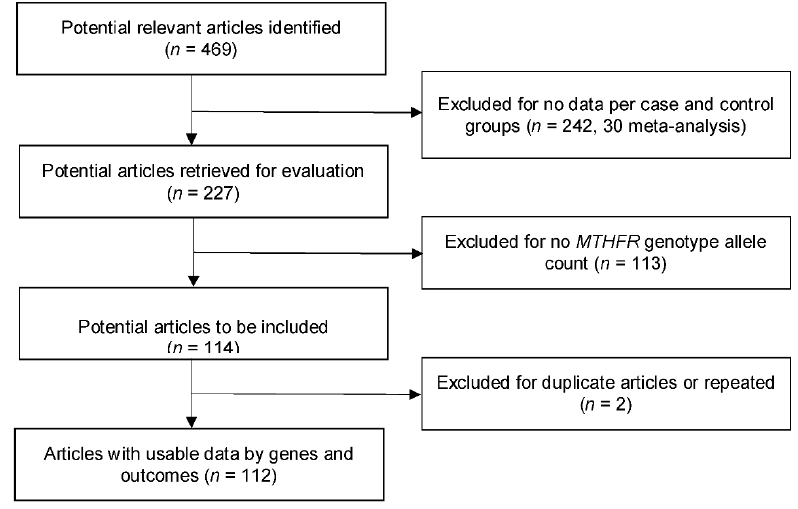
Figure 1. Progression of the selection of studies for the meta-analysis.